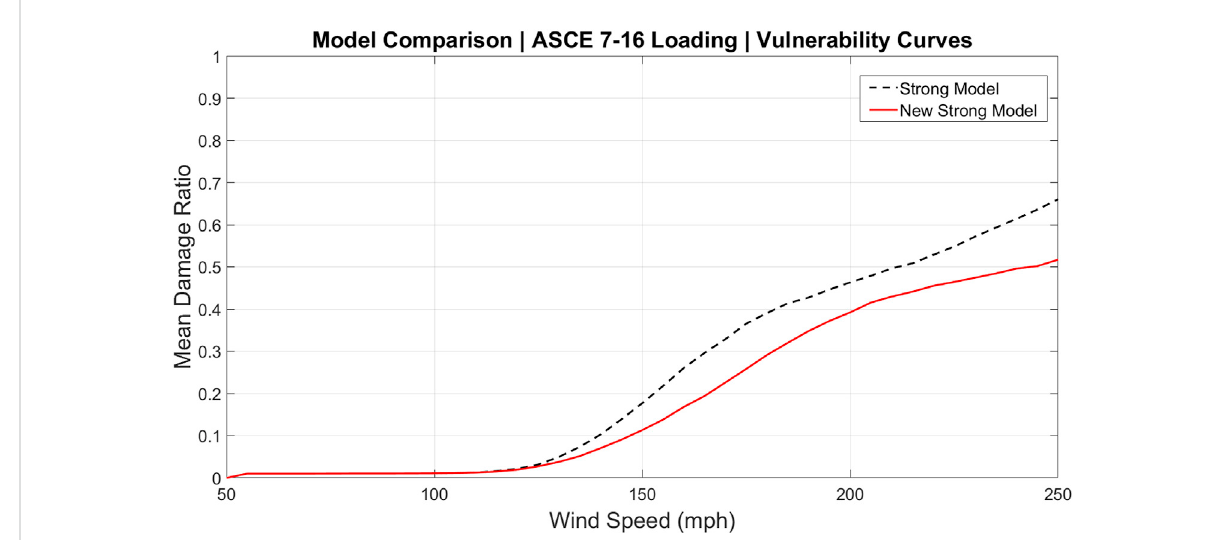
FIGURE 8 Vulnerability curves of the strong and new strong models under ASCE 7 – 16 loading.